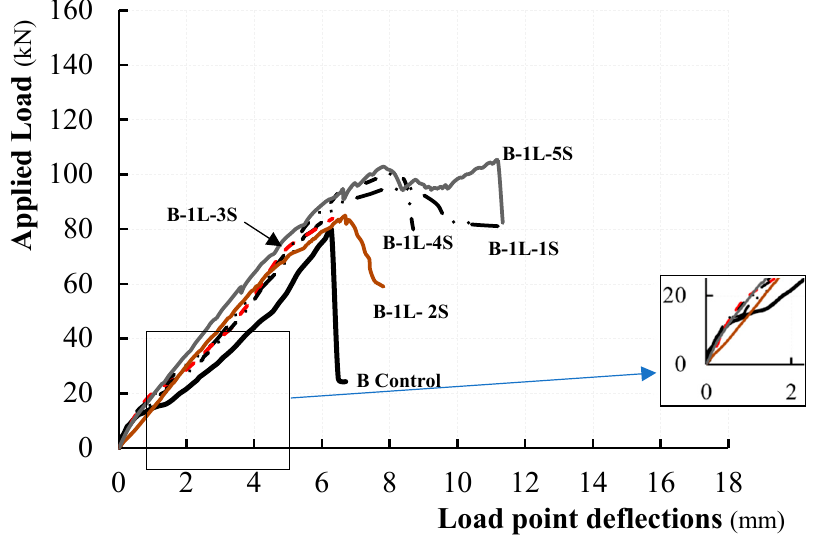
Figure 10. Load–deflection curves for beams strengthened with one layer of steel fabrics.